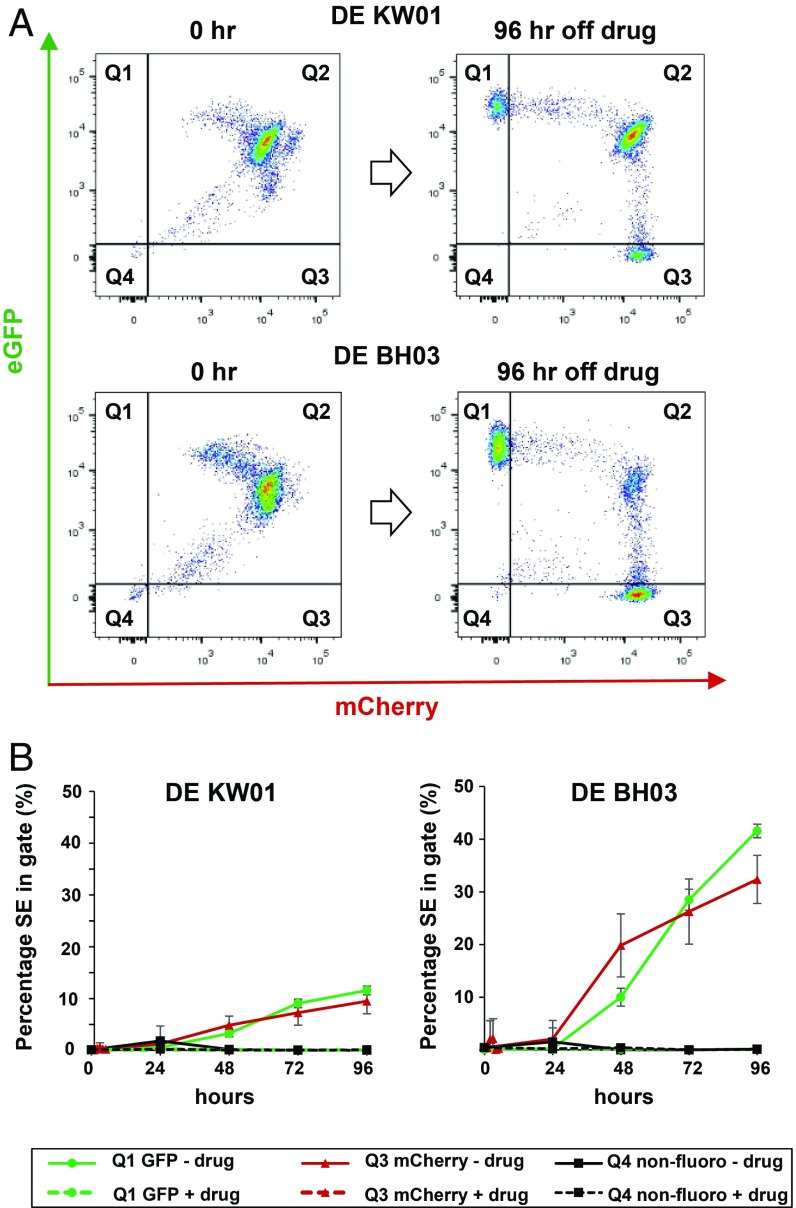
Removal of double-expresser strains from double drug-selection pressure results in loss of the double-expresser (DE) phenotype with strain-dependent kinetics. (A) Double-expresser lines DE KW01 and DE BH03 were removed from drug selection for the time indicated in hours (h). Representative flow cytometry traces are shown with quadrants containing populations positive for eGFP (Q1), mCherry (Q3), both eGFP and mCherry (Q2), or nonfluorescent (Q4). Quadrants are based on 98th percentile gating. (B) Quantitation of the percentage of single-expressers (cells in quadrants Q1 or Q3) present in populations of DE KW01 or DE BH03 after removal of drug selection. Values shown are the average ± standard deviation (SD) of 3 biological replicates.